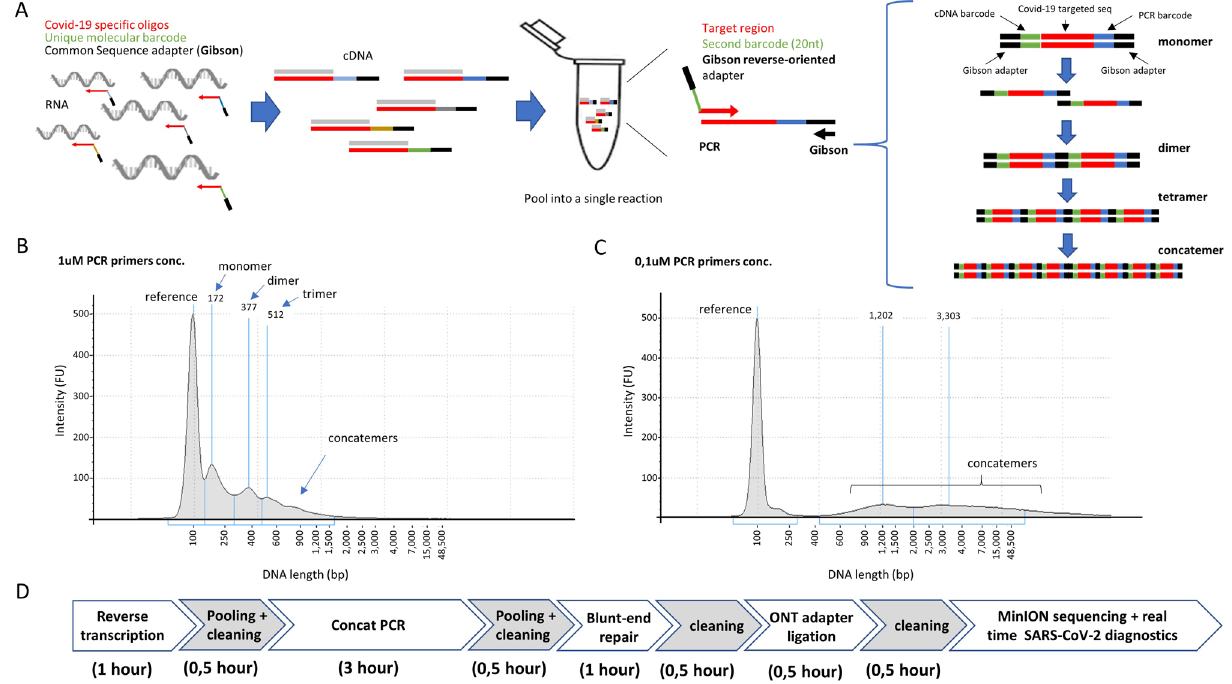
Figure 2. Dual molecular DNA barcoding and PCR-driven concatemerization applied to SARS-CoV-2 diagnostics. ( A ) Reverse transcription is performed with oligonucleotides targeting a Covid-19 region, but in addition containing a unique molecular barcode per sample and a common adapter sequence (Gibson). Reverse transcription assays (cDNA) performed for multiple candidates are pooled together for amplification.